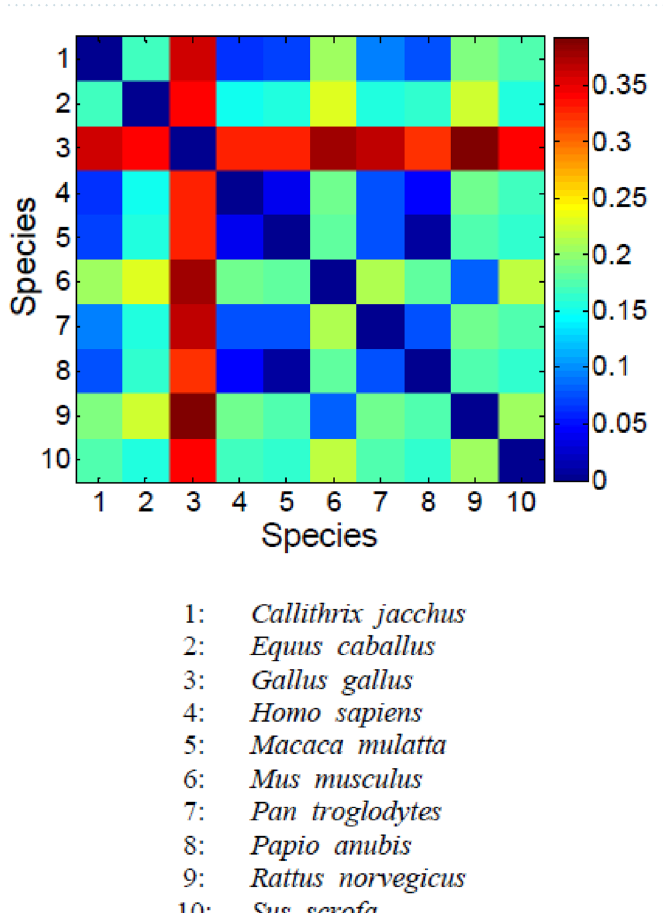
Figure 3. Scatter plot of three PC values. Circle (aqua color): Cluster 1 consists of Equus caballus, Sus scrofa ; Circle (indigo color): Cluster 2 consists of Homo sapiens, Callithrix jacchus, Pan troglodytes, Macaca mulatta, Papio anubis ; Circle (yellow color): Cluster 3 consists of Mus musculus, Rattus norvegicus ; Circle (maroon color): Cluster 4 consists of Gallus gallus .